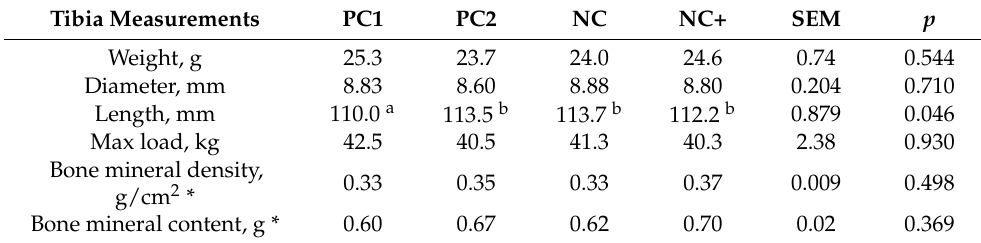
Table 4. Tibia bone strength parameters of broilers offered the different experimental